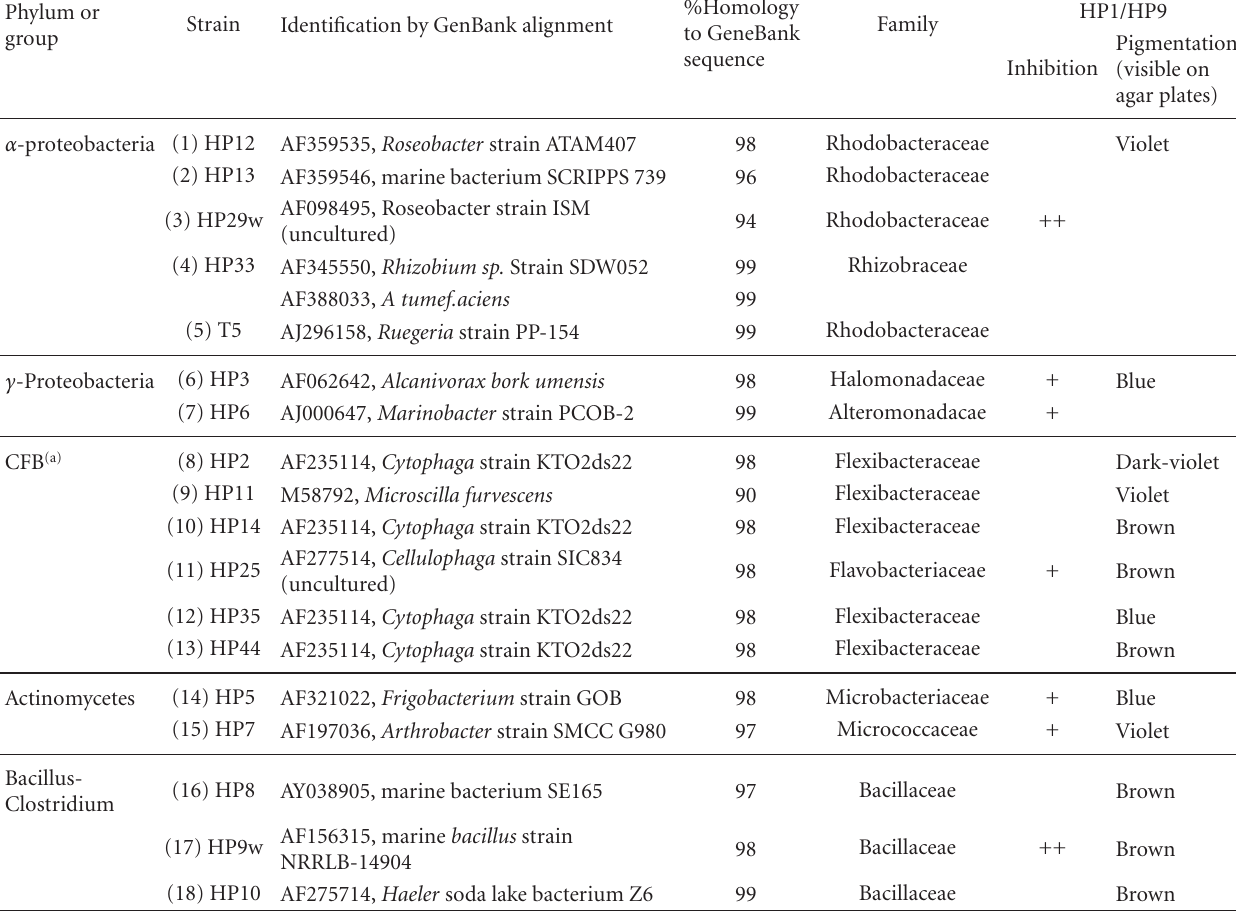
Table 1: Growth inhibition and influence on pigment production of HP1 and HP9 by other strains during cocultivation on agar plates (see Figure